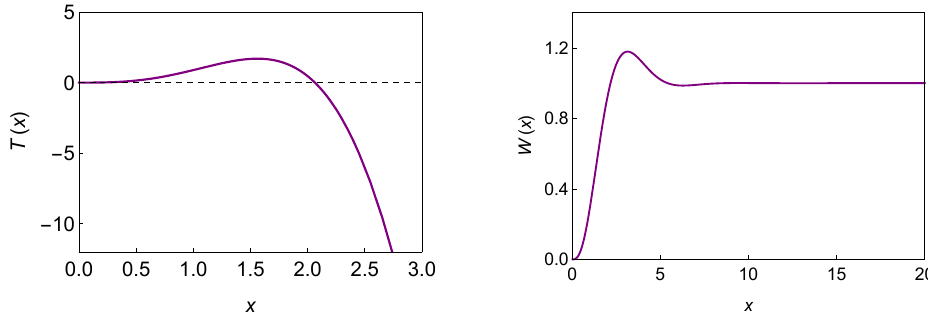
Figure 9 . Left panel: plot of the function (6.30). Right panel: plot of (6.33).